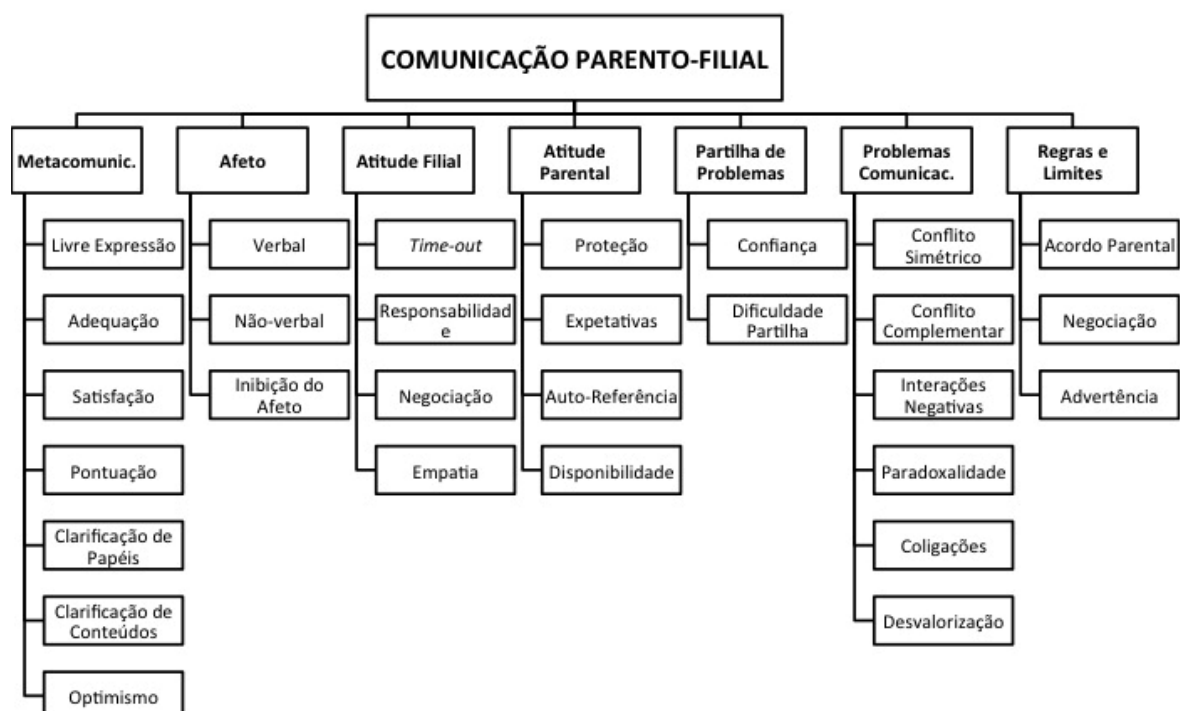
Figura 1 . Árvore de Categorias elaborada pelo software